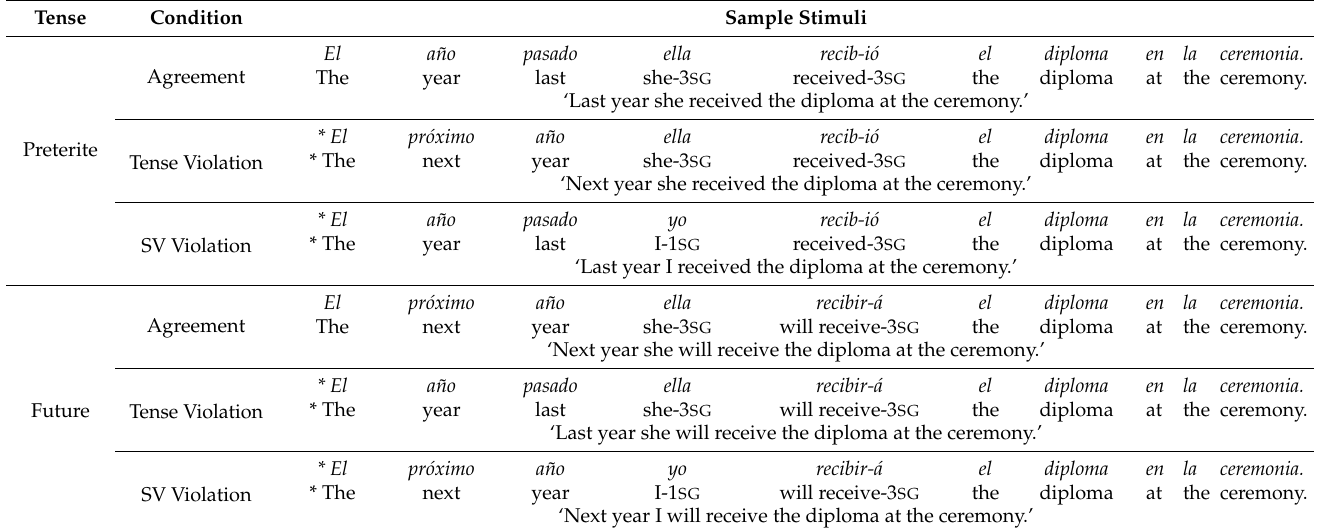
Table 3. Examples of Experimental Sentences for the Self-Paced Reading Assessment.